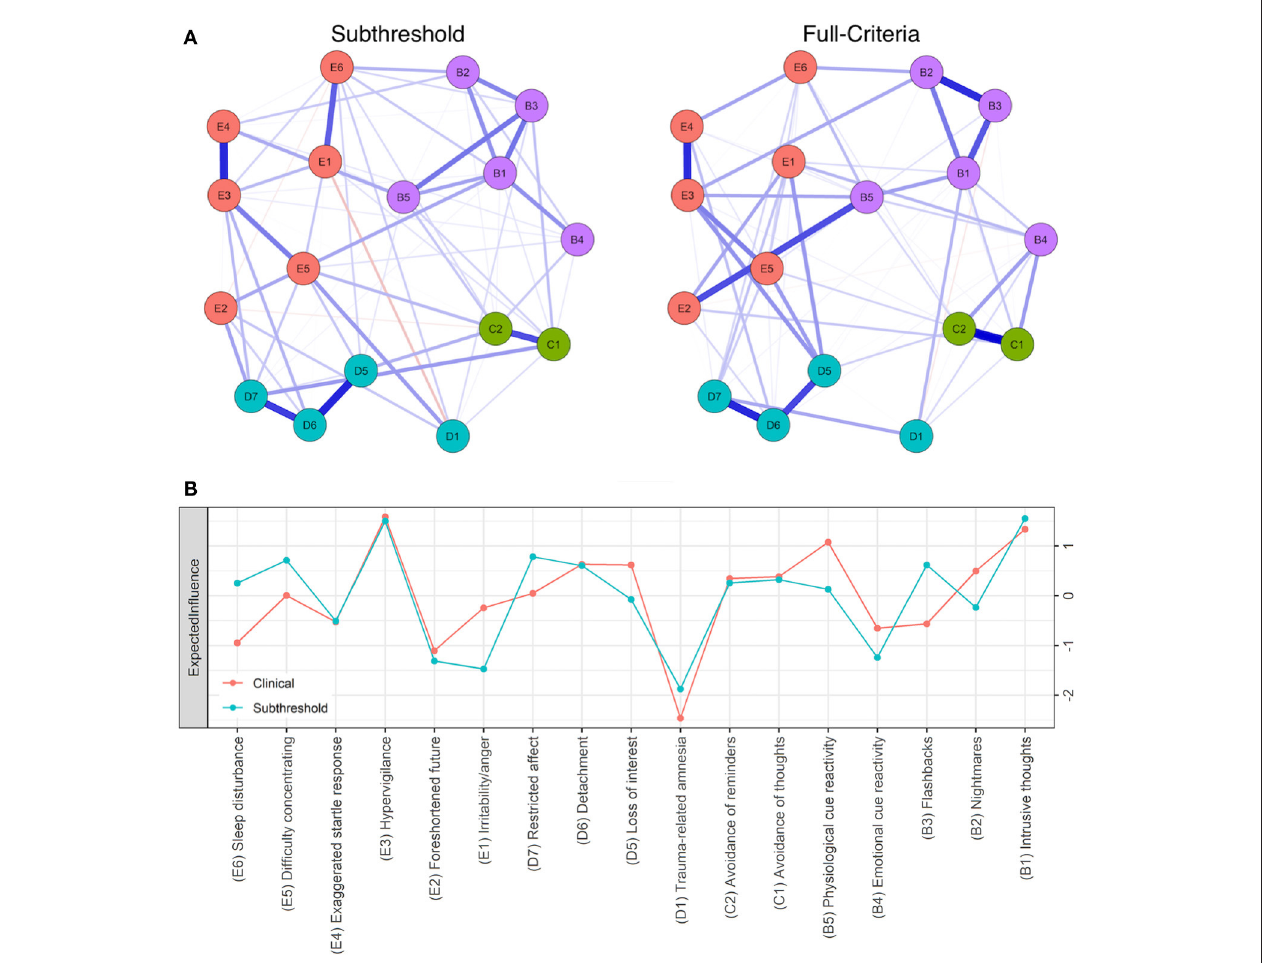
FIGURE 1 | (A) Seventeen-node DSM-IV PTSD symptom network comparison for full-criteria (left) and subthreshold (right) groups. Blue lines represent positive associations, red lines negative ones, while the width and brightness of an edge indicate association strength. Both networks are set to the same maximum edge (0.48) for comparison. (B) Individual node strength values shown as standardized z-scores for full-criteria (orange) vs. subthreshold PTSD (blue).